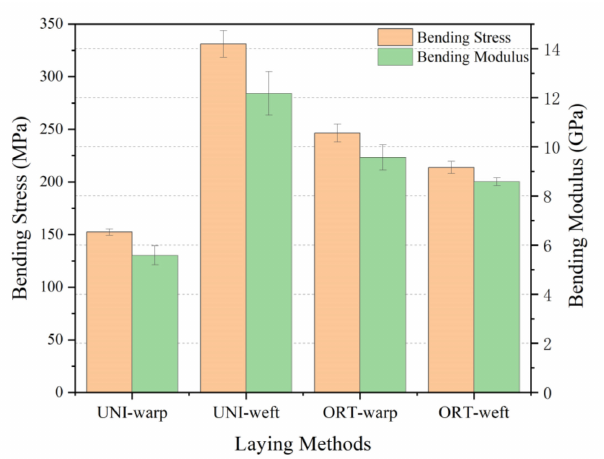
Figure 10. Bending properties of 3D armor materials under different layup